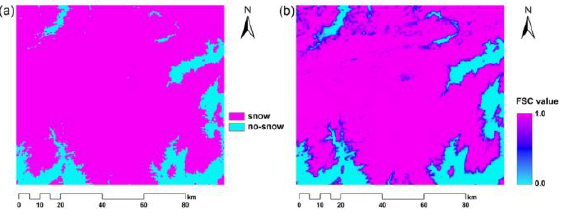
Figure 8: (a) Reference binary snow map of the test area obtained from Landsat ETM+ data, and (b) FSC map of the test area generated by the MLP-tansig